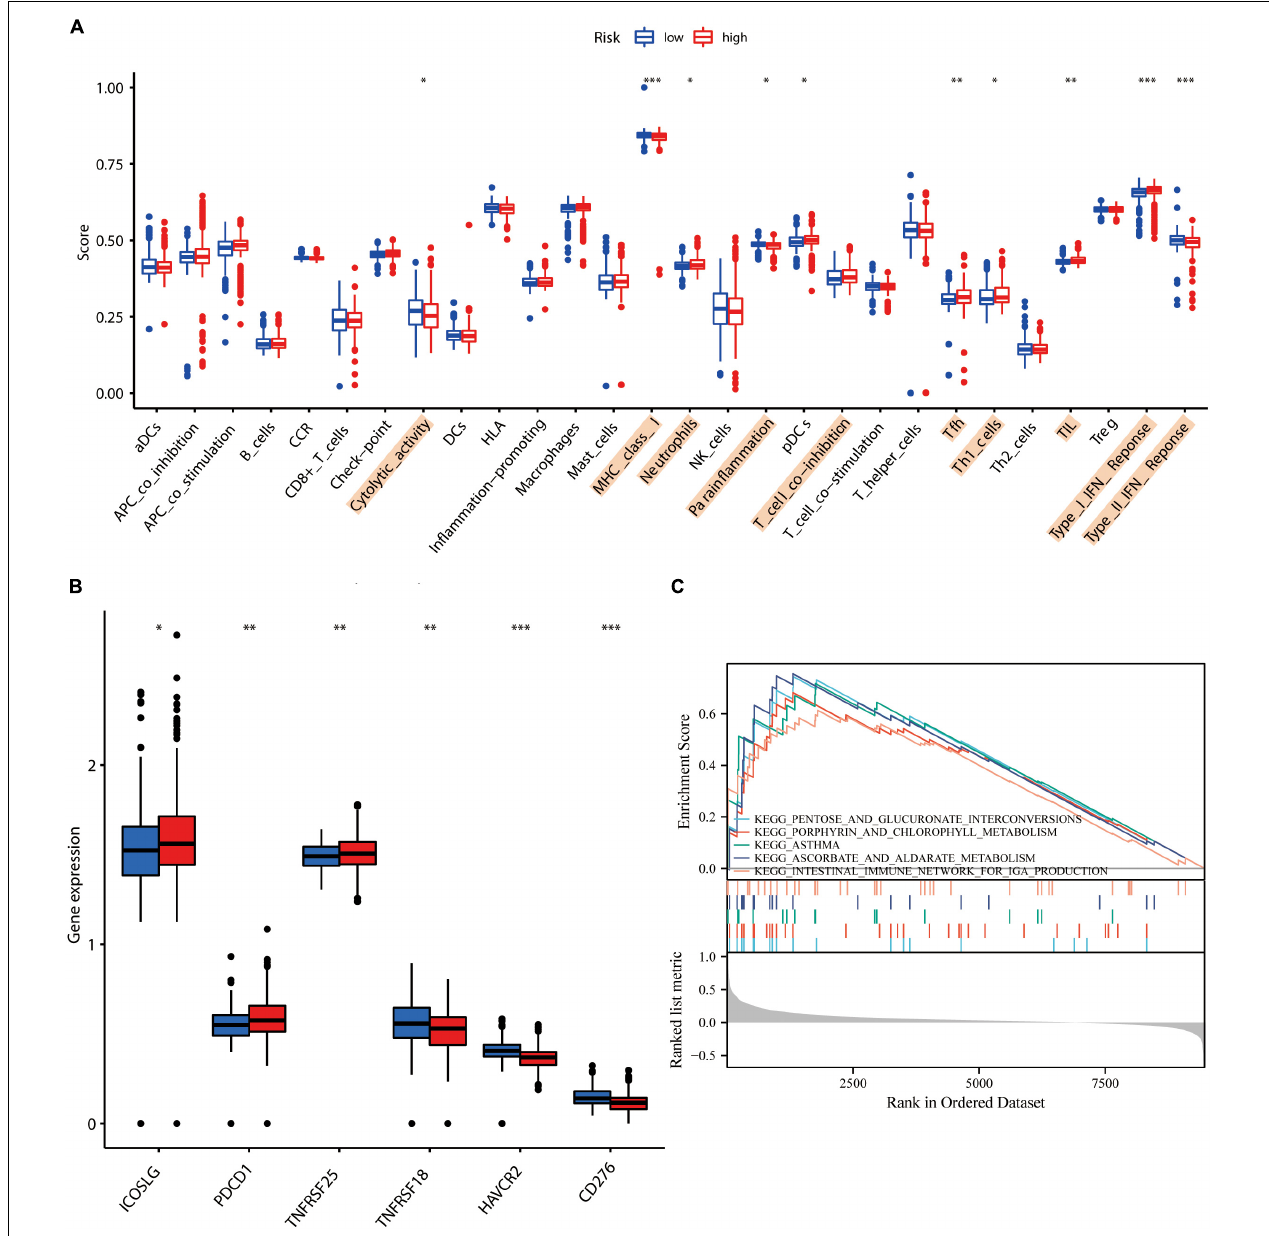
FIGURE 4 | Correlation study of AD risk score scores with local immune characteristics. (A) Immune cell infiltration analysis based on ssGSEA. (B) Correlation of high and low AD risk scores with immune checkpoints. (C) GSEA enrichment analysis based on AD scores. ∗ represents p -value < 0.05, ∗∗ represents p -value < 0.01, and ∗∗∗ represents p -value <